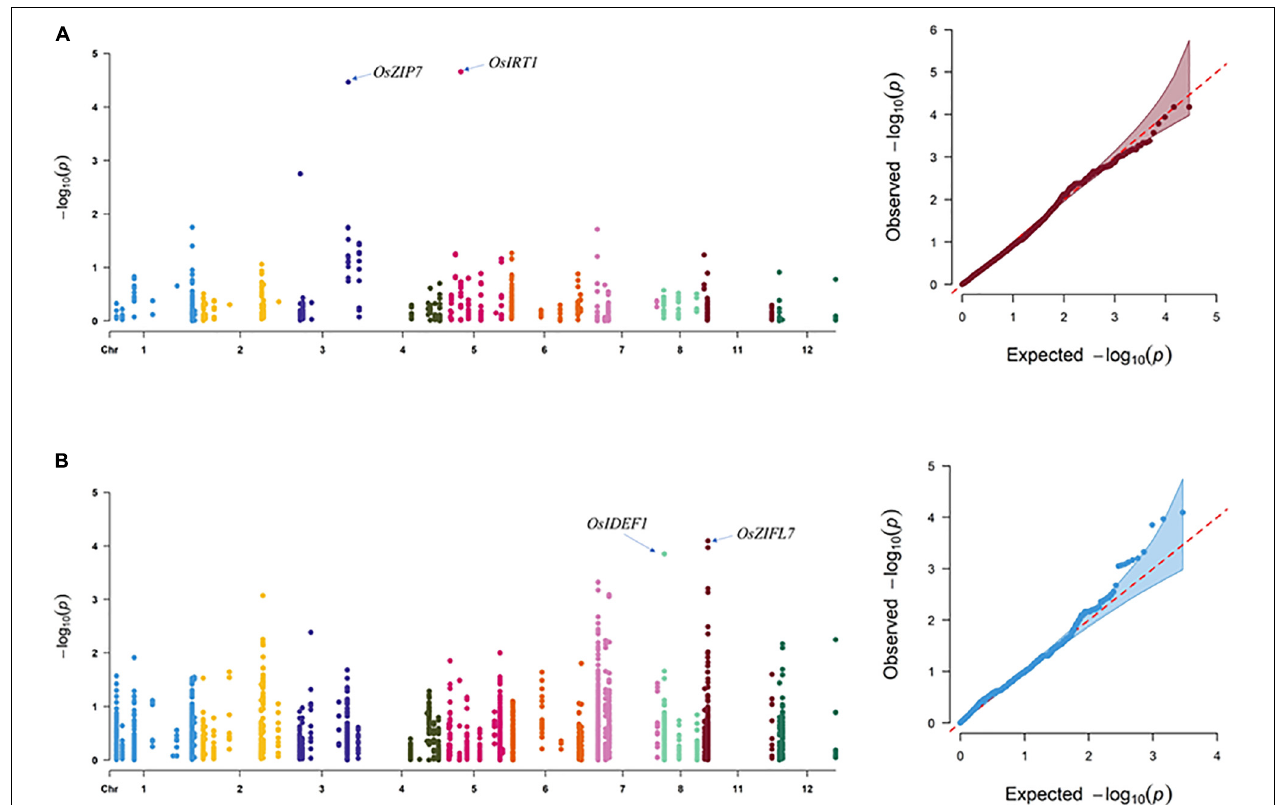
FIGURE 2 | Association analysis for grain Zn content by SL-MLM in the SEA and SC panels. (A) SEA panel and (B) SC panel.